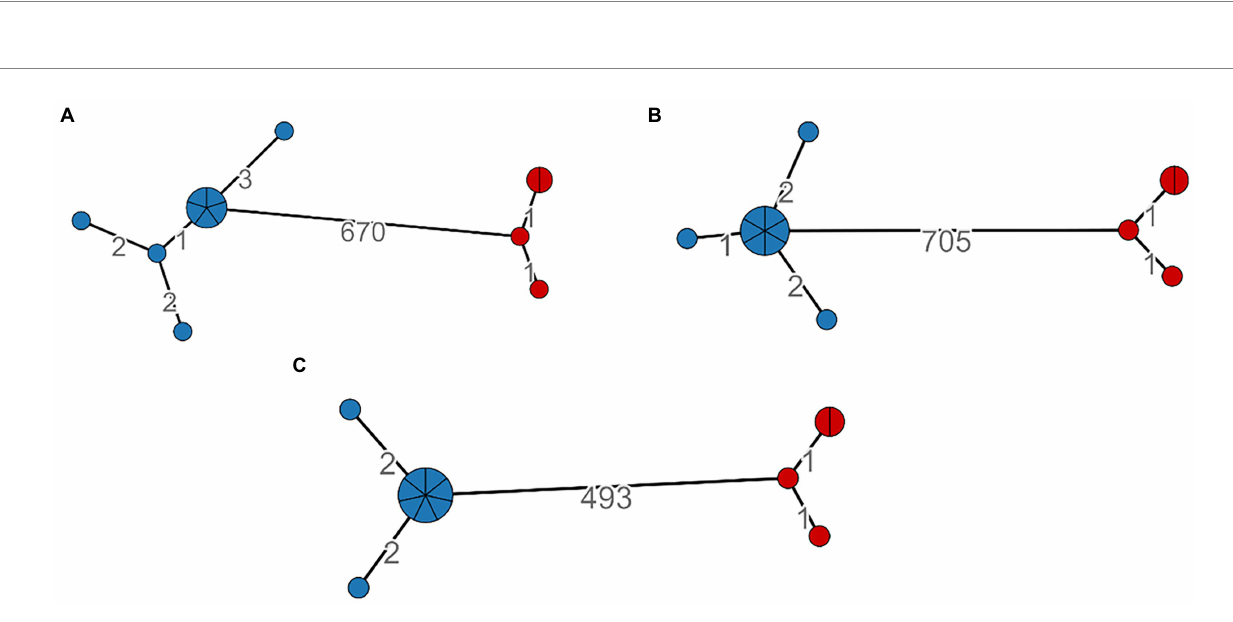
FIGURE 4 SNP-based Minimum spanning tree and clusters identification based on distance <6; Cluster 1: Blue, Cluster 2: Red. (A) —SRS, (B) —HYBR, (C)